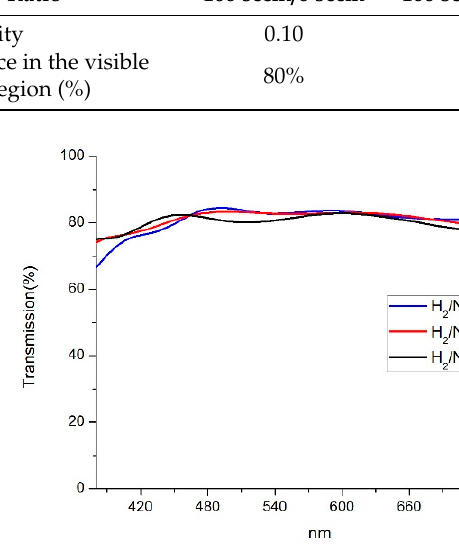
Figure 4. Transmission spectra of the H 2 /N 2 plasma with different N 2 flow processed AZO/ITO films.